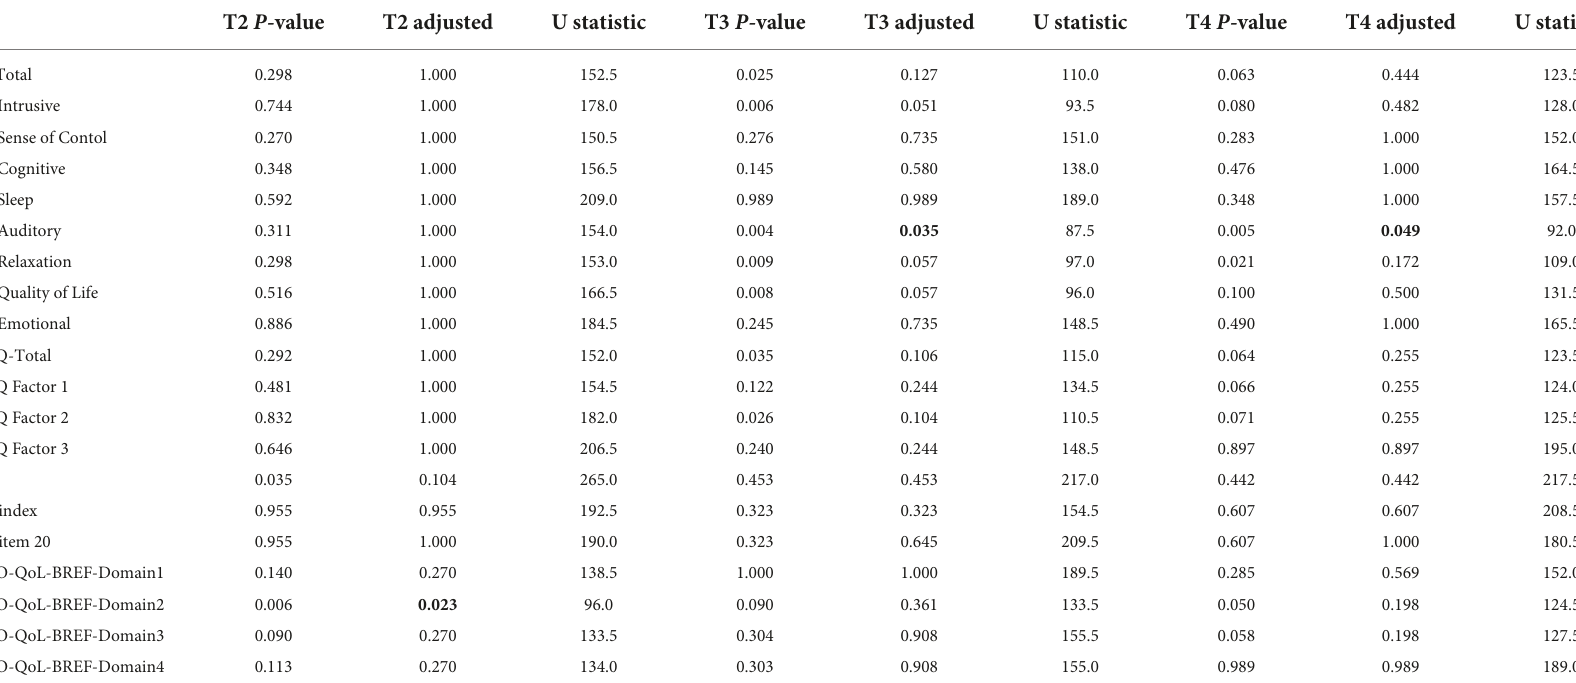
TABLE 6 Statistical significance of our outcomes at various evaluation points measured as a difference relative to T1 using a non-parametric Mann-Whitney U -test and further adjusted for multiple comparisons by the Holm